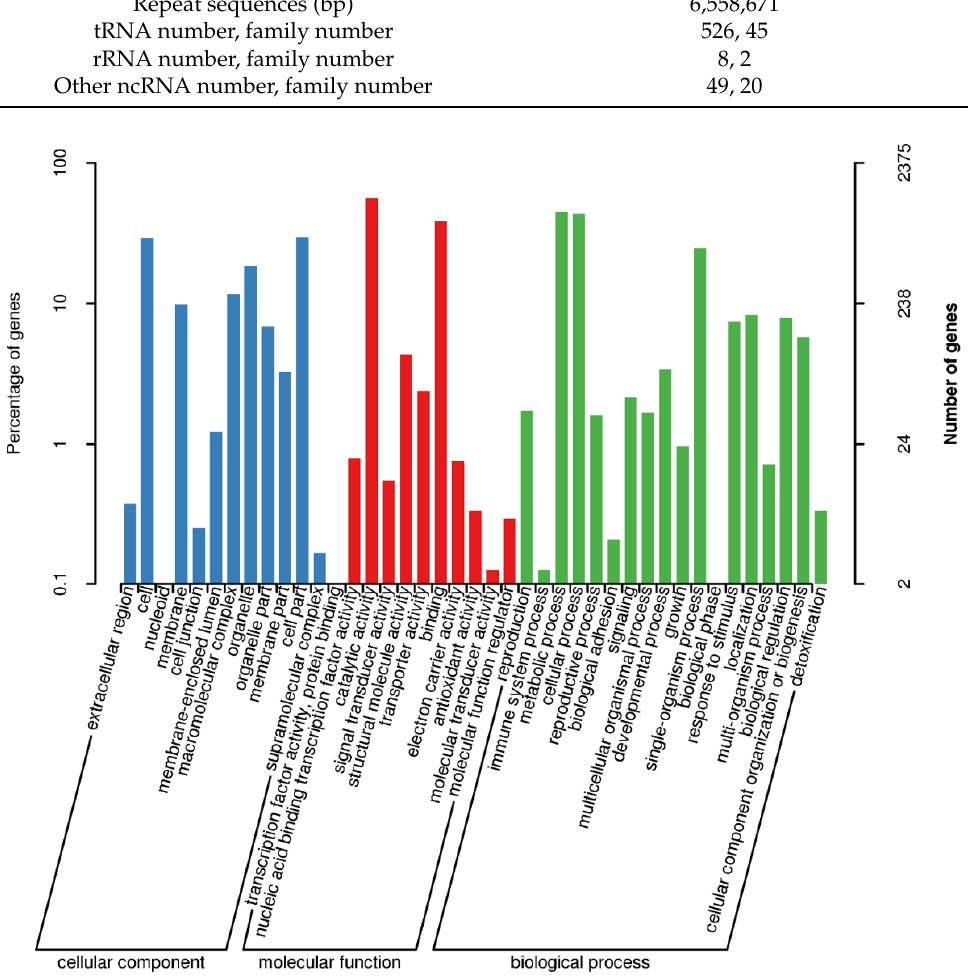
Figure 1. GO functional annotation of the C. obscurus genome. The x -axis shows in different colors the protein-coding genes divided into three major categories. The left y -axis represents the percent of genes (%) while the number of the genes are represented by the right y -axis.